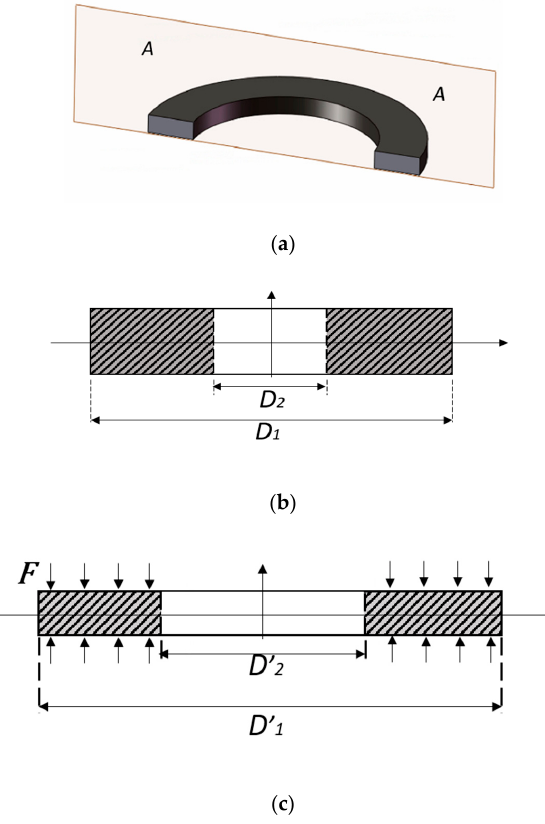
Figure 3. Figures to illustrate that pre-load changes induce circumferential strain change of a washer. ( a ) A 3D view of a washer with A-A cross-sectional view; ( b ) A 2D A-A cross-sectional view of washer without torque applied; ( c ) The 2D A-A cross-sectional view of washer with torque applied.